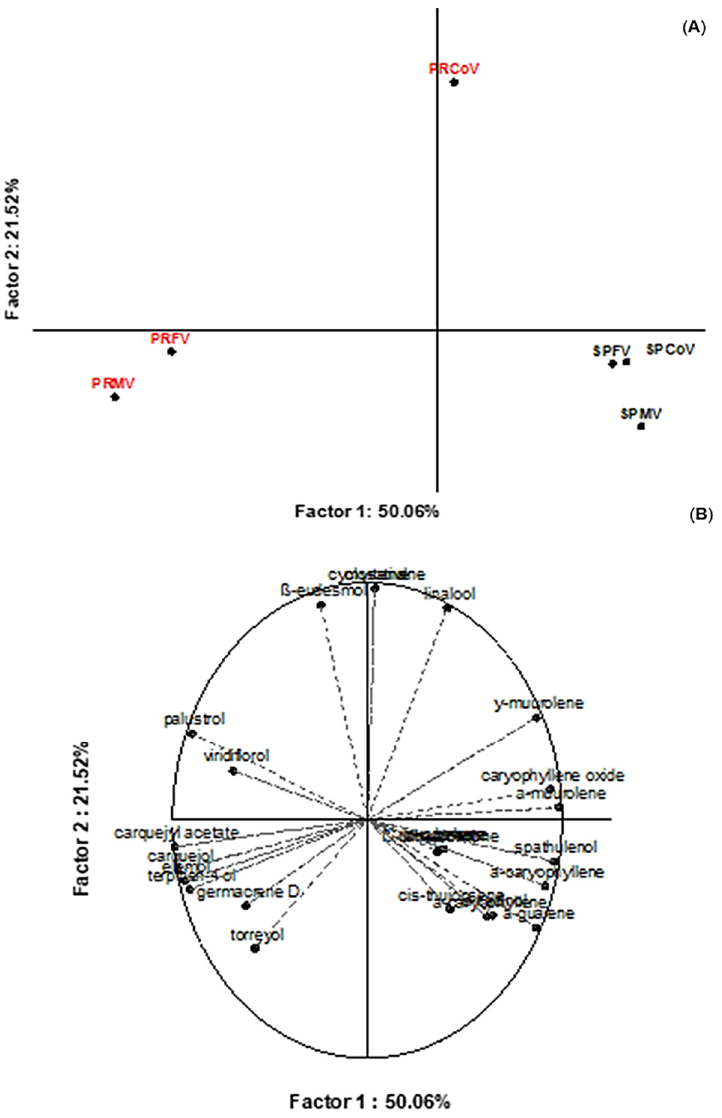
Figure 1. Projection of B. myriocephala and B. trimera samples according to the levels of volatile compounds in the essential oils ( A ) and the factor loadings ( B ). The red color represents the essential oils from Paraná State and the black color is related to the essential oil from São Paulo State. V = essential oil, Co = commercial samples, F = female specimens, M = male specimens, SP = São Paulo state, and PR = Paraná state